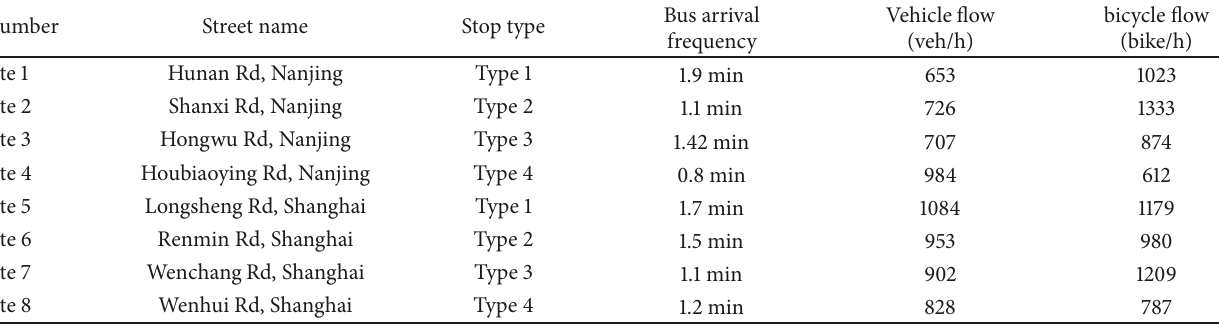
Table 1: Information of study sties [21].